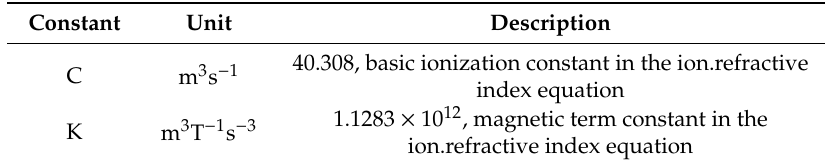
Table 3. Input constants for the bi-local correction in the rOPS.